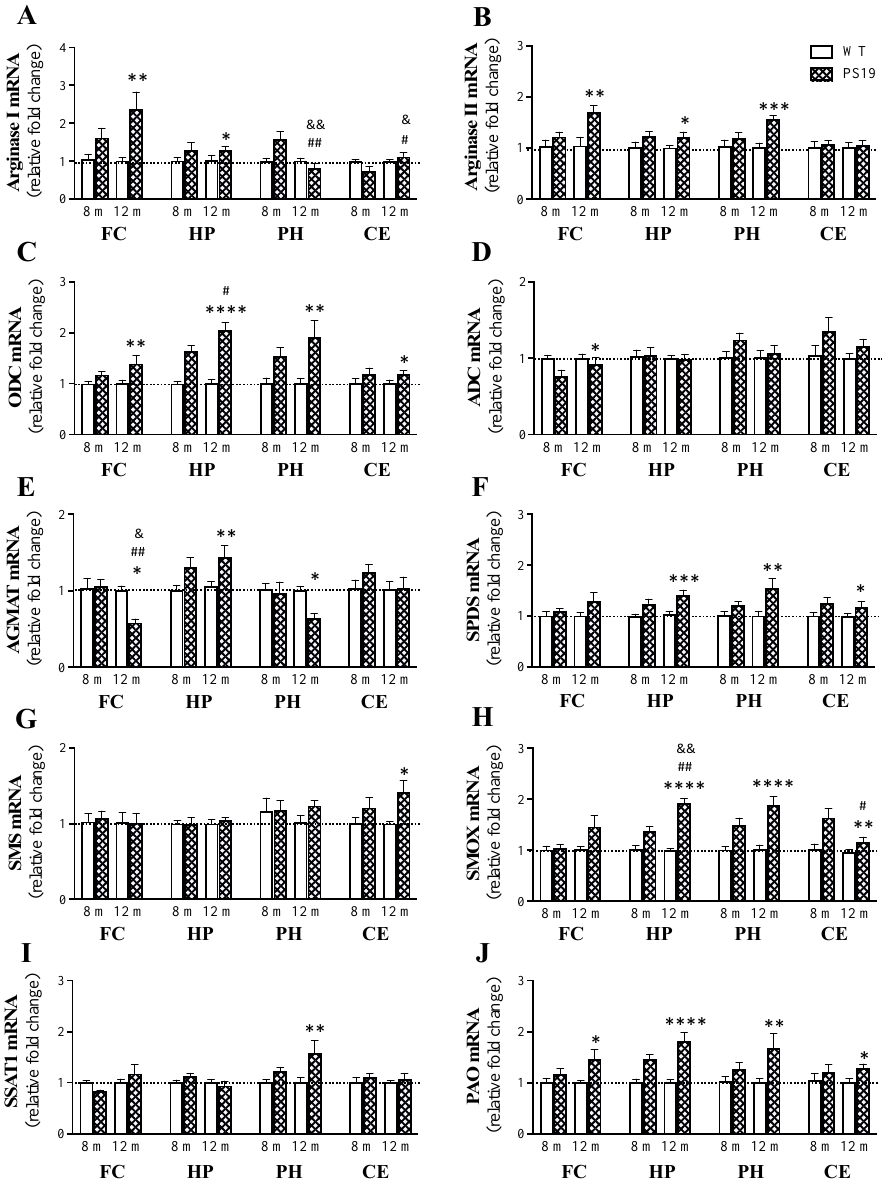
Figure 5. Mean ( ± SEM) relative fold change (2 − ∆∆ Ct ) of mRNA expression of arginase I ( A ), arginase II ( B ), ornithine decarboxylase (ODC, C ), arginine decarboxylase (ADC, D ), agmatinase (AGMAT, E ), spermidine synthase (SPDS, F ), spermine synthase (SMS, G ), spermine oxidase (SMOX, H ), spermidine/spermine-N 1 -acetyltransferase-1 (SSAT1, I ) and polyamine oxidase (PAO, J ) in the frontal cortex (FC), hippocampus (HP), parahippocampal region (PH) and cerebellum (CE) of wildtype (WT) and PS19 mice at 8 and 12 months (m) of age (n = 6 – 8/genotype/age). & indicates a significant genotype and age interaction at & p < 0.05 or && p < 0.01. # indicates a significant age effect at # p < 0.05 or ## p < 0.01. * indicates a significant genotype effect at * p < 0.05, ** p < 0.01, *** p < 0.001 or **** p < 0.0001.